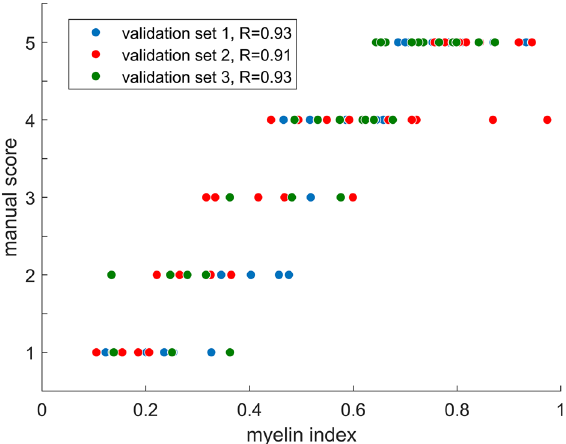
Figure 6. Comparison of myelination index with manual scoring. Shown are manual scoring, on a scale of 1–5, against myelination index values, across individual cells. Colors show datasets of different conditions and time. Also shown are Pearson correlation coefficients for each